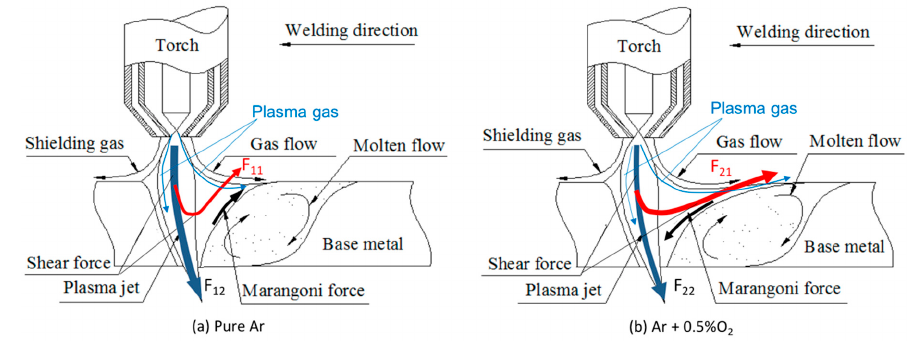
Figure 15. Influence of shear force and Marangoni force on the material flow behavior of the KPAW weld pool. ( a ) Pure Ar, ( b ) Ar + 0.5% O 2 .